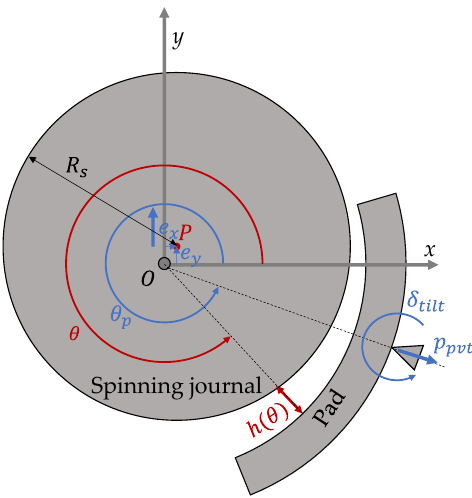
Figure 4. Schematic diagram for the calculation of the fluid film thickness.